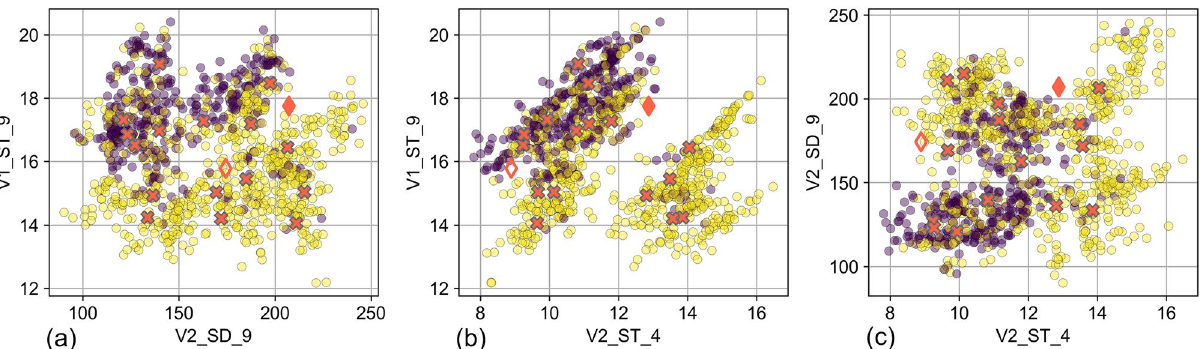
Figure 3. Views of the model. 2D scatter plots with all 1056 observations from 2006 to 2021 for the three pairs of variables in the selected 3D model. V1_ST_9 in ( a ) and ( b ): the mean soil temperature in September of the previous year, V2_SD_9 in ( a ) and ( c ): the total sunshine duration in September of two years before, and V2_ ST_4 in ( b ) and ( c ): the mean soil temperature in April of two years before. Yellow (hex color code #FDE725FF) corresponds to observations with low risk, whereas indigo (hex color code #440154FF) corresponds to observations with high risk. The overlaying red x-markers indicate the values of the variables from each year averaged over whole Germany, called cluster centers. The red diamond markers indicate the average values over Germany for 2022 (filled markers) and for 2023 (unfilled